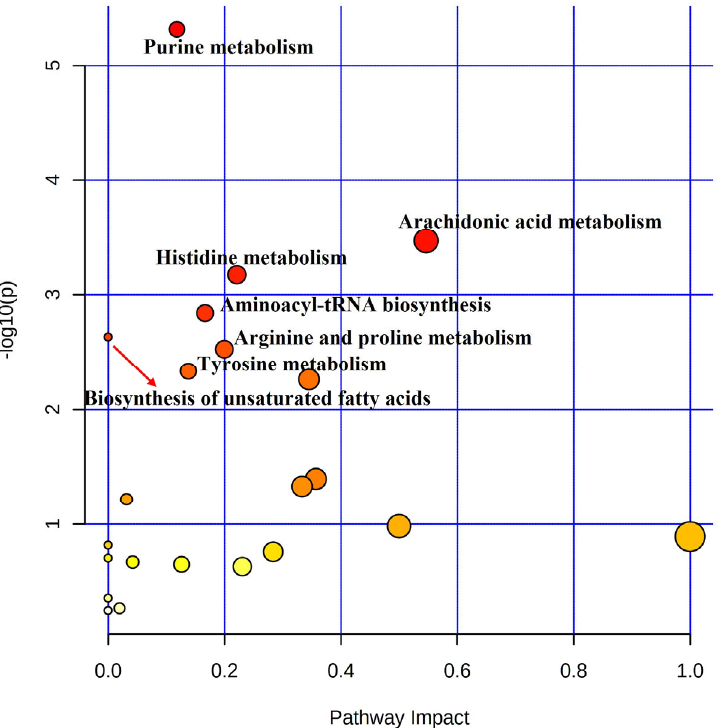
Figure 5. Metabolic pathway enrichment analysis. The manipulated metabolic pathways are based on the analysis of the differentiated ruminal metabolites of yaks fed hay or high-grain diets following the Bos taurus Kyoto Encyclopedia of Genes and Genomes (KEGG) pathway database, using MetaboAnalyst v.4.0. The x-axis represents the pathway to impact, and the y-axis represents the pathway enrichment. Larger sizes and darker colors indicate greater pathway enrichment and higher pathway impact values,